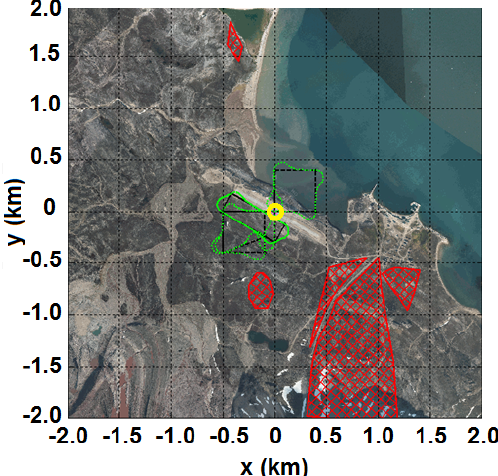
Figure 9. Flight path of the UAS ALADINA (start point in the cen- ter, marked in yellow) in order to study the vertical and horizontal distribution of aerosol particles above ice surfaces near glaciers and over open water. Research flights were spatially limited by restricted areas (hatched in red), like a bird sanctuary near the coast and in- strument areas south of Ny-Ålesund, and no activity was performed over inhabited buildings of the village. The TopoSvalbard map© is obtained from the Norwegian Polar Institute and retrieved from http://toposvalbard.npolar.no, last access: 29 June